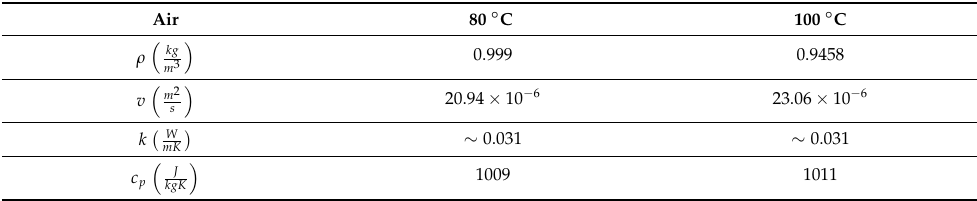
Table 1. ρ , v , k , c p values of air at 80 ◦ C and 100 ◦